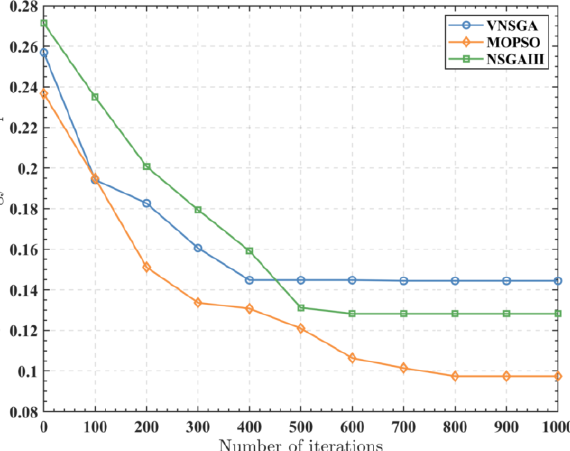
Figure 12. Hyper volume, Delta, and NDS for three algorithms from different iterations for 100 m R s max and 200 m R c max with respect to area A.